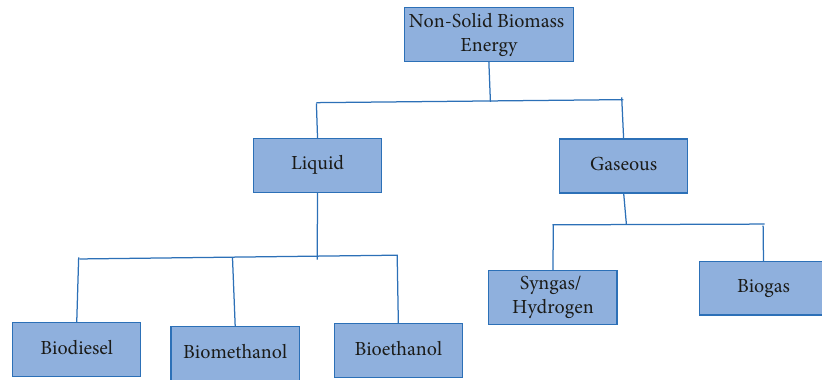
Figure 5: The classification of nonsolid biomass